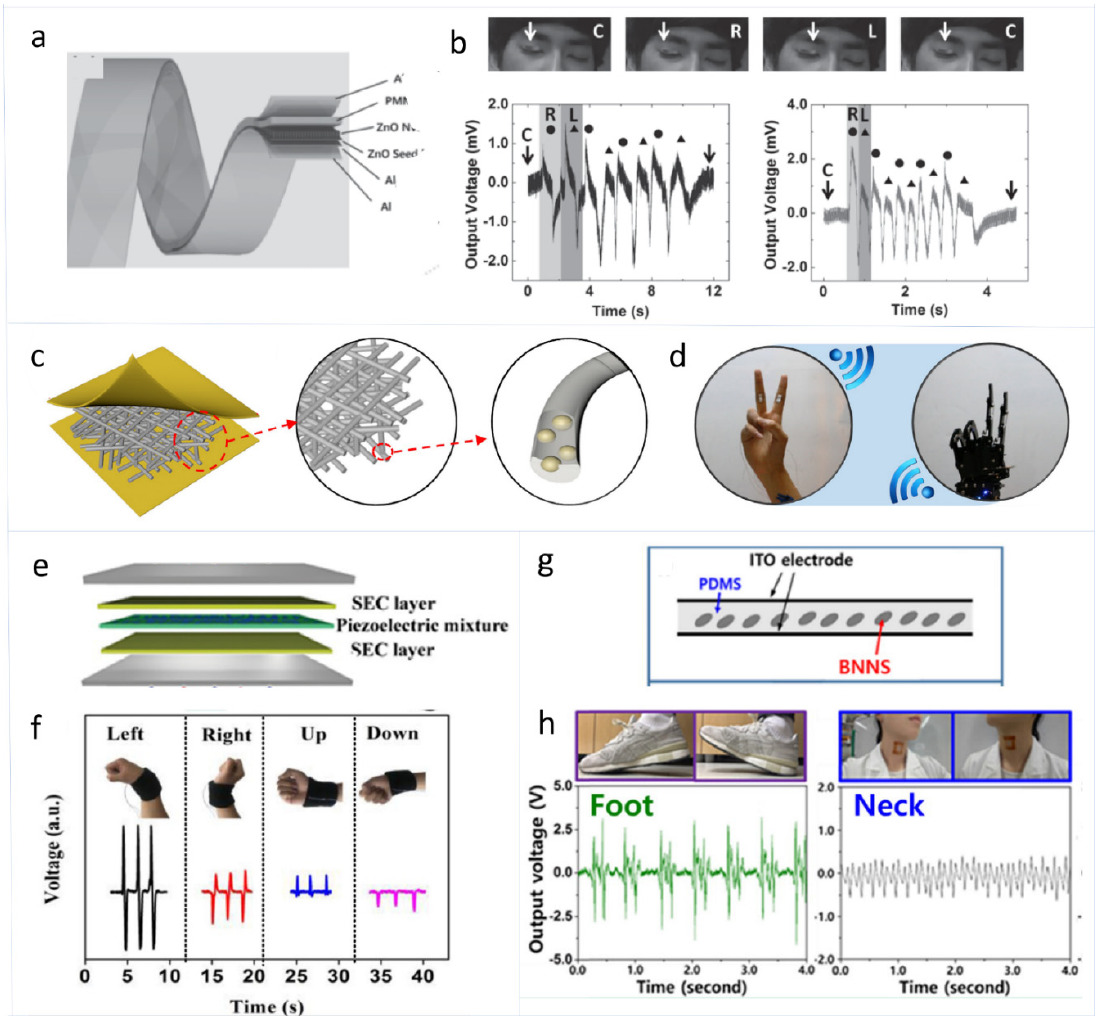
Figure 3. ( a ) Schematic illustration of the structure of super-flexible PENG. ( b ) The PENG attached to the right eyelid as an active sensor for detecting the motion of a human eye ball. Output voltage measured under slow and rapid eye movement [36]. Copyright 2015, Wiley. ( c ) The structure design of the cowpea-structured PVDF/ZnO nanofibers based PENG. ( d ) The application of robot hand control based on the skin PENG [53]. Copyright 2018, Elsevier. ( e ) Schematic illustration of the device structure of the PENG. ( f ) The output voltage of the PENG working as a “smart wristband” under different wrist gestures [60]. Copyright 2018, Elsevier. ( g ) Schematic diagram of the structure of the boron nitride nanosheet based piezoelectric sensor. ( h ) Open-circuit voltage of the device during foot and neck motions [63]. Copyright 2018, Elsevier. Table 1. Comparison of self-powered skin sensors for detecting body motion. Output Power Mechanism Material Motion Detected Reference Density Diaphragmatic breathing and 76.27 W m (cid:2879)(cid:2870) [35] TENG Rubber and Al joint movements Rubber and Swallowing, calf raising, TENG physiological jumping, squatting, breathing, [49] saline bicep curling, and gait patterns PDMS and Au Bending and relaxation of joints [50] TENG nanosheets film